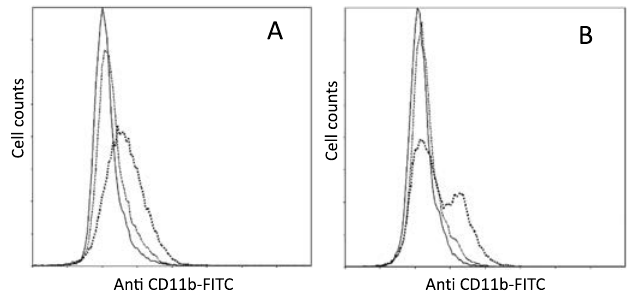
Figure 3 Results of flow cytometry showing inositol hexaphosphate- induced CD11b expression In A) PLB-985 and B) X chromosome linked gp91-phox gene knockout cells following incubation with 0 mM (solid line), 5 mM (broken line), and 10 mM (dotted line) inositol hexaphosphate for 72 h. Each histogram shows the CD11b level (measured as signal intensity of antibody fluorescein isothiocyanate) on the X-axis versus cell count on the Y-axis.